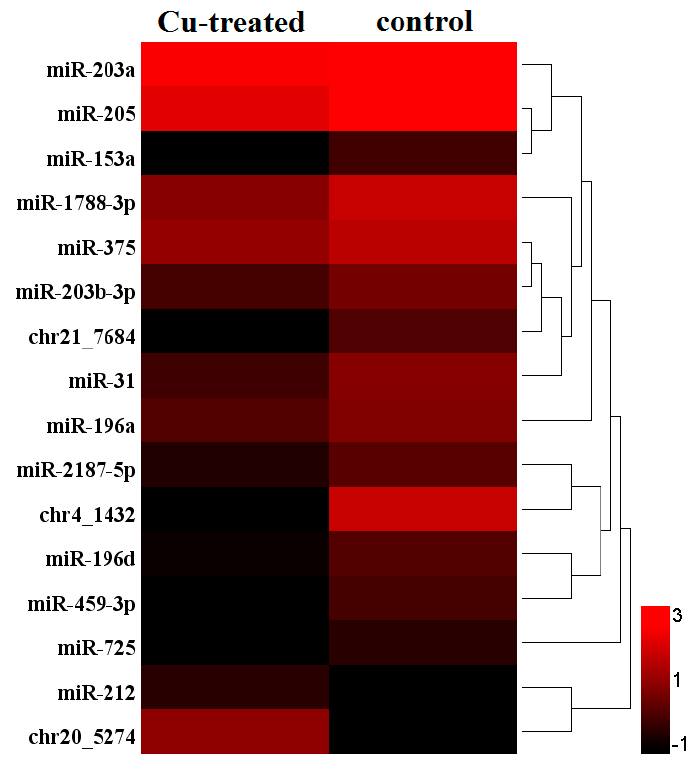
Figure 2. Hierarchical clustering of differentially expressed miRNAs between the two groups. The heat map was drawn with log 10 NE of each miRNA. Color from dark to light indicate low frequency to high frequency miRNA between the control and Cu-exposed group. Color map was used to distinguish the difference of expression.